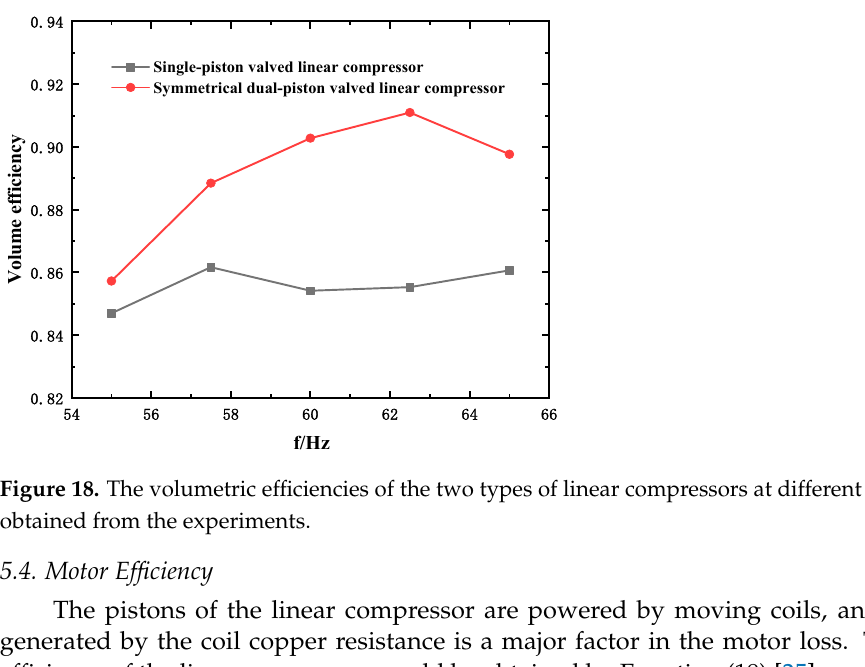
Figure 17. The volumetric efficiencies of the two types of linear compressors at different pressure ratios, obtained from the experiments.